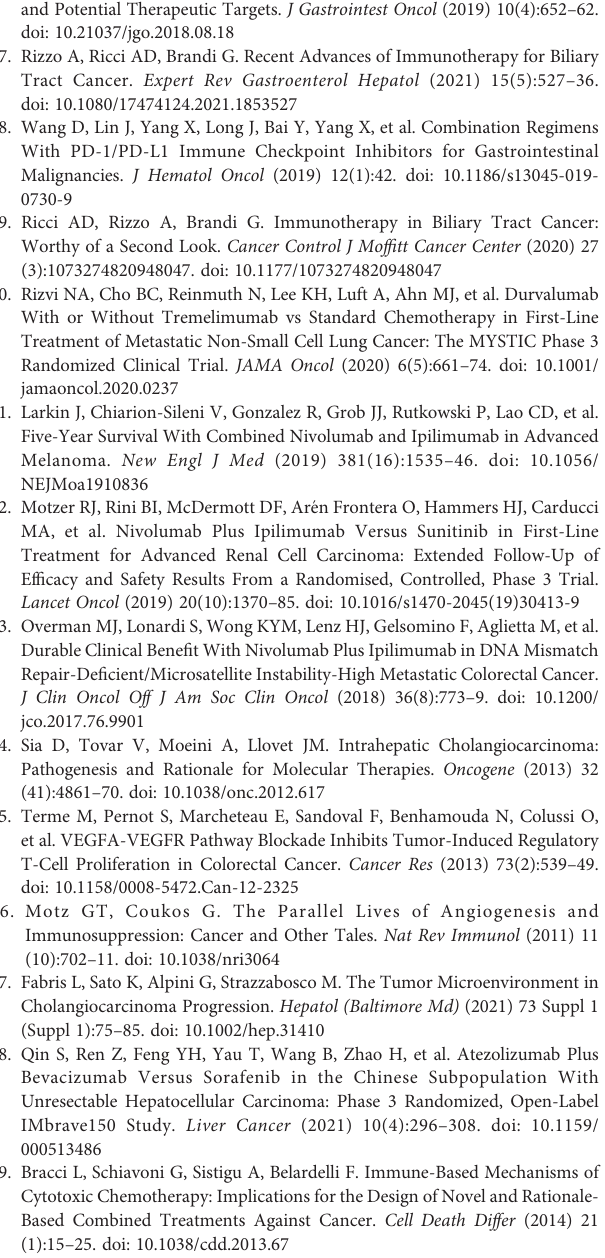
Supplementary Figure 2 | Forest plot of any-grade AEs in anti-PD1-containing regimens and anti-PDL1-containing regimens. (A) Anti-PD1-containing regimens; (B) anti-PDL1-containing regimens. Three studies had more than one subgroup of interest. Speci fi cally, patients were allocated to nivolumab group [Ueno2019(1)]